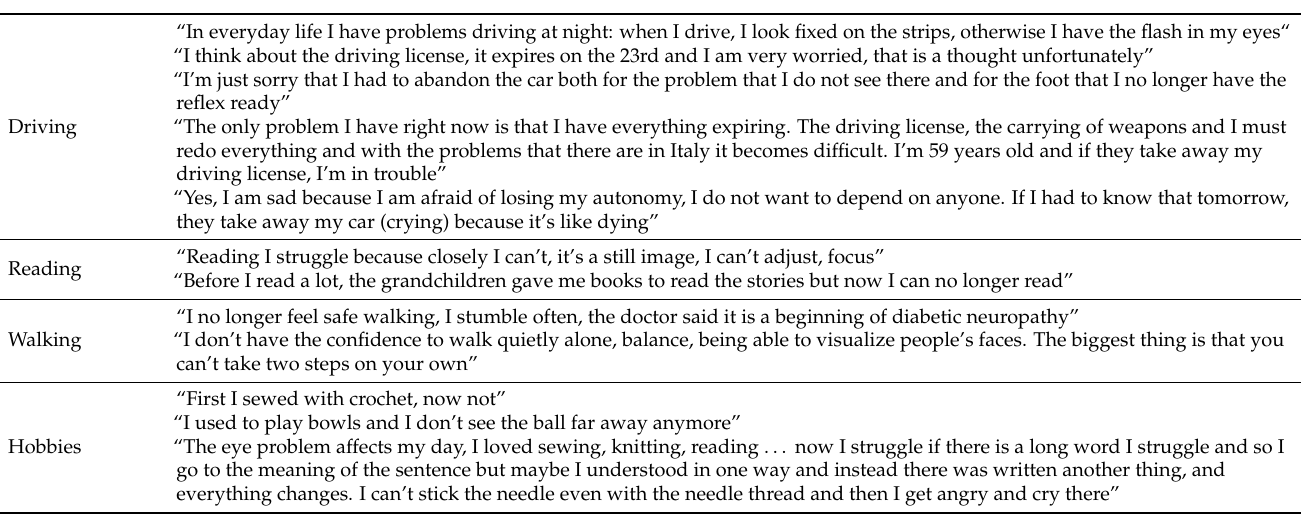
Table 2. Impact on quality of life.